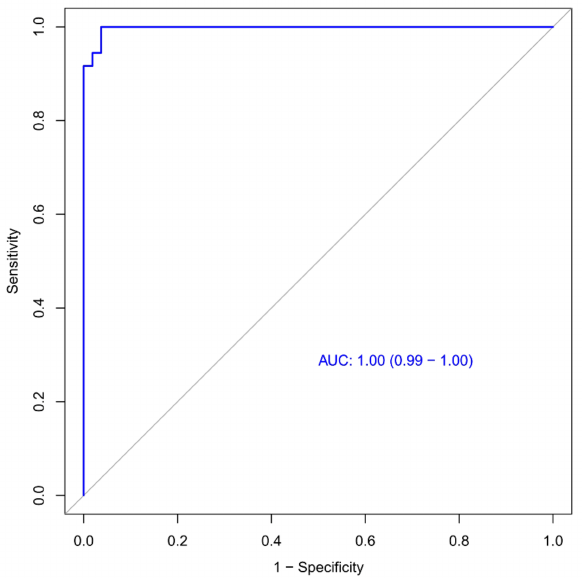
Figure 10. Receiver operating characteristic (ROC) curve for the first model. The AUC (area under the ROC) was 0.99 for the model.